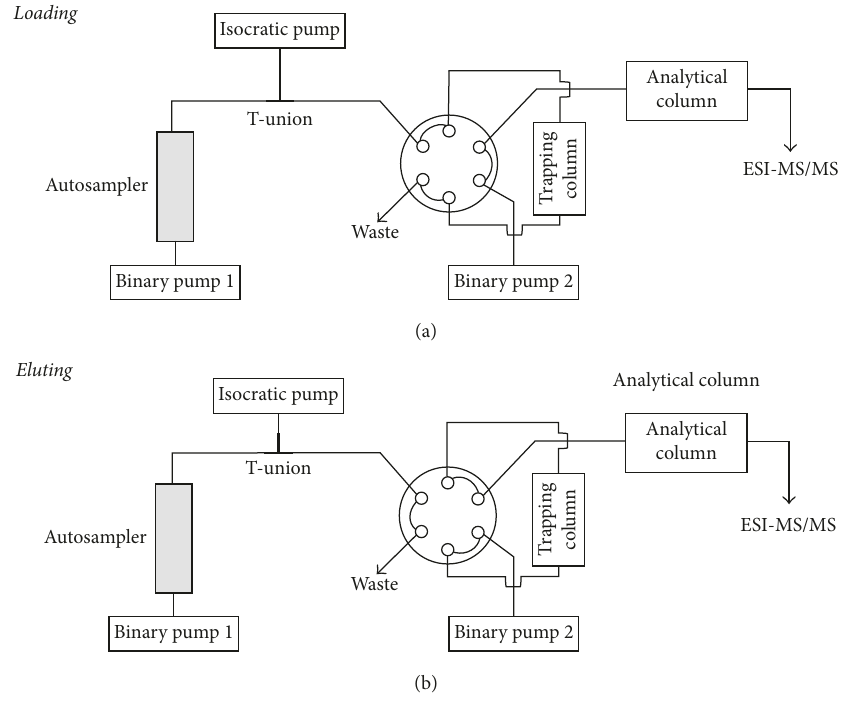
Figure 2: LC-MS/MS